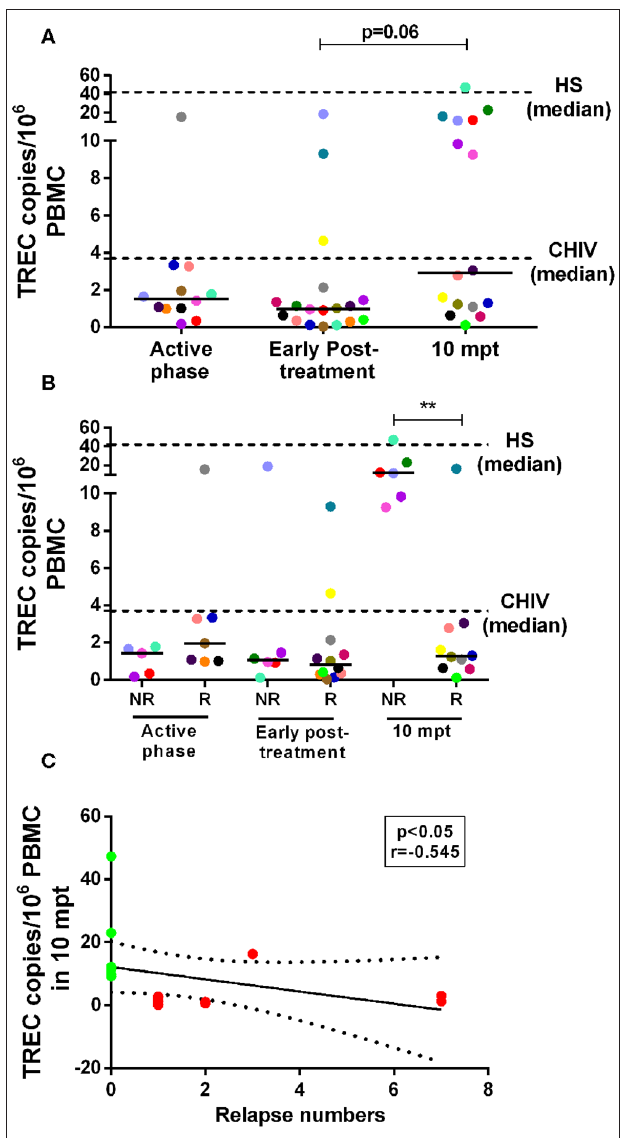
FIGURE 5 | Number of T cell receptor excision circles (TREC) copies/10 6 PBMC in visceral leishmaniasis/HIV (VL/HIV) co-infected patients during the prospective follow-up and its correlation with number of VL relapses. TREC copy numbers in the VL/HIV-co-infected patients (A) and TRECS copy numbers in non-relapsing-VL/HIV (NR-) and relapsing-VL/HIV (R-) group (B) during the clinical follow-up. The number of TREC copies was evaluated from 1 to 5 × 10 6 cells/mL obtained of the peripheral blood of all VL/HIV co-infected patients in the active, early post-treatment and 10 mpt phases, as well as HIV mono-infected patients (CHIV) and healthy subjects (HS). Negative correlation (C) between the number of TREC copies at 10 mpt and the total number of relapses presented by VL/HIV patients (Spearman correlation, r = − 0.545; p < 0.05). The green and red colors represent the NR-VL/HIV and R- patients, respectively (C) . The dashed lines represent the median of TREC copies/10 6 PBMC of the HIV mono-infected patients and HS (A,B) . Each point represents a patient and each color represents the same patient in the different phases of follow-up. The horizontal bar represents the median values. 10 mpt (10 months post-treatment). ** p <